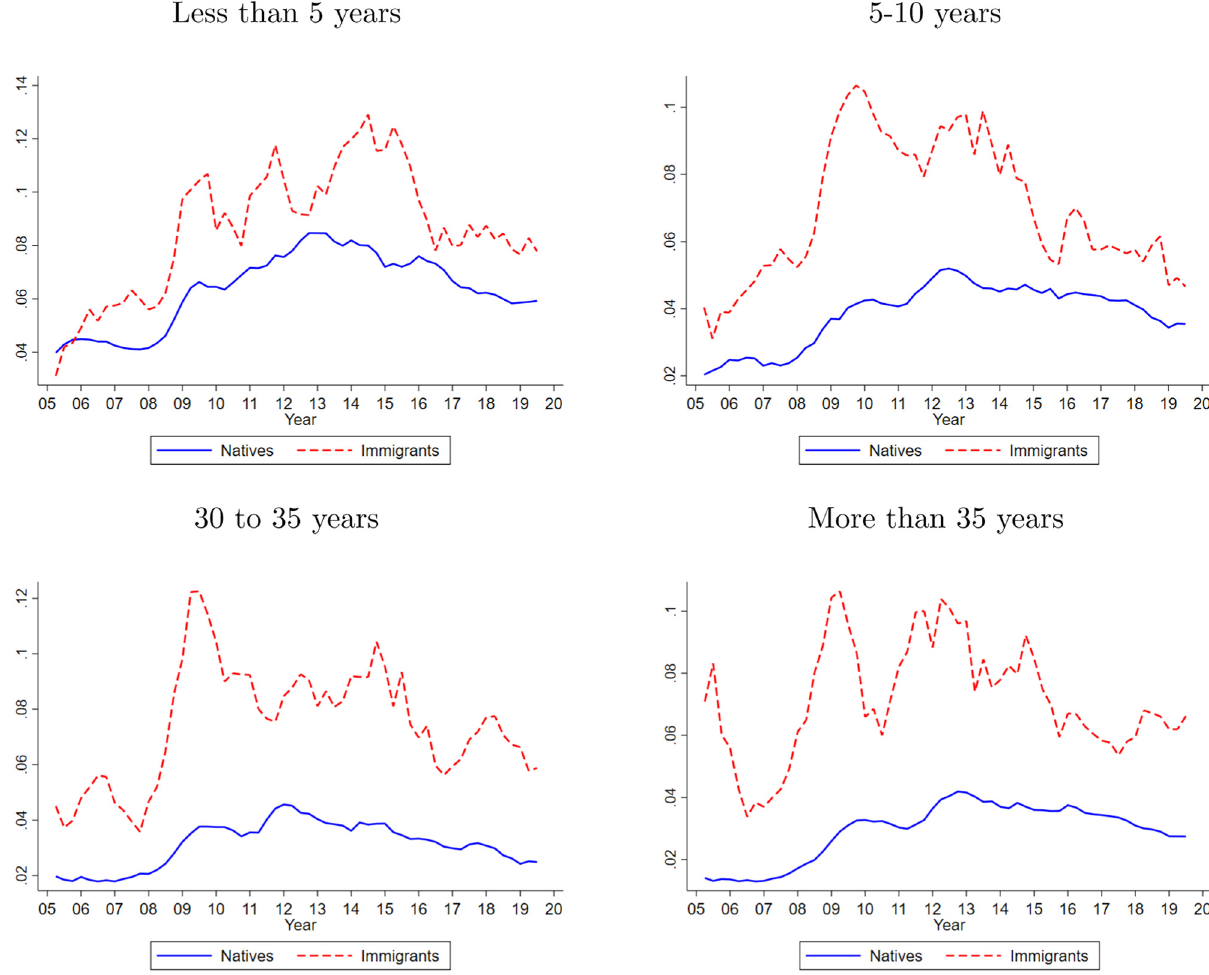
Figure A4: Job - separation rate by nationality and experience. Note: The transitions are seasonally adjusted using a 4 - quarters moving average, constructed from the Spanish Labour Force Survey -